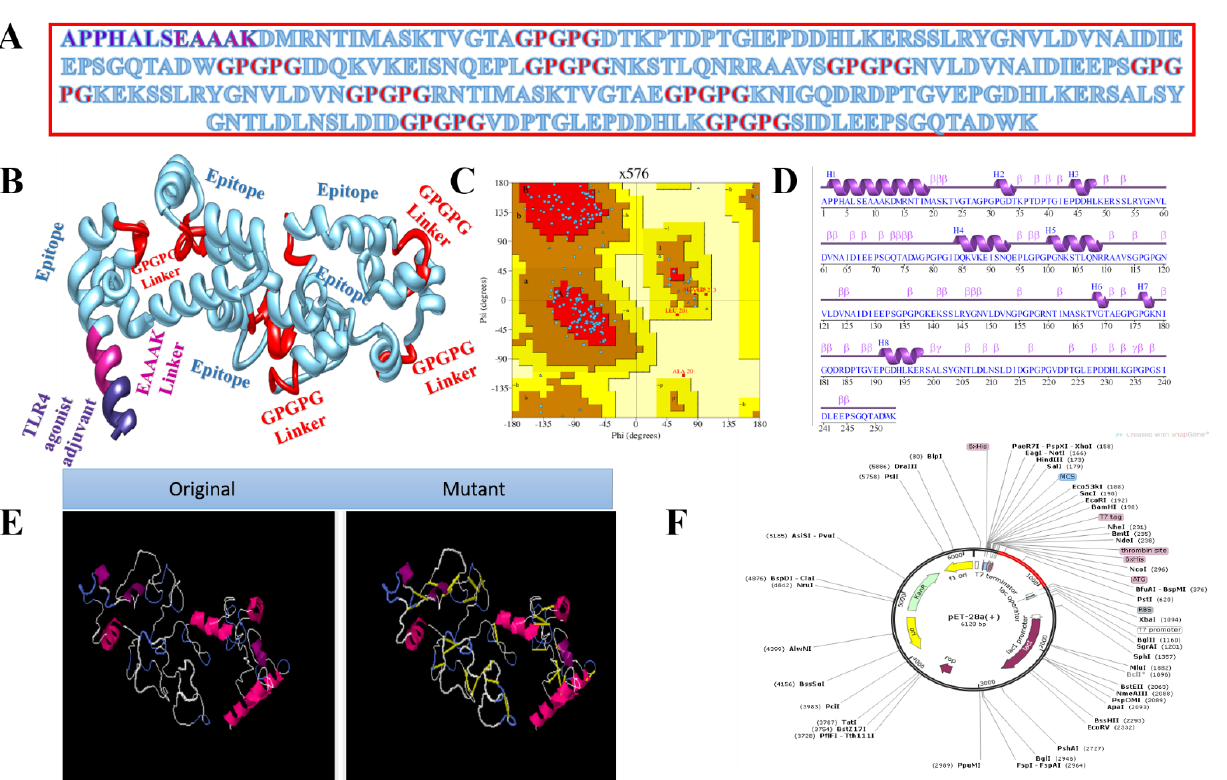
Figure 3. Structure characterisation of model vaccine with TLR4-agonist adjuvant ( A ) amino acid sequence, ( B ) 3D structure of TLR4-agonist vaccine, ( C ) Ramachandran plot, ( D ) secondary structure elements, ( E ) original versus mutated structure, and ( F ) cloned vaccine into expression vector.